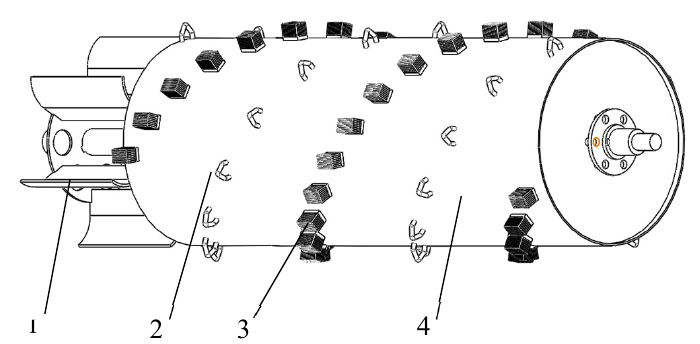
Figure 13. The 3D structure diagram of separation drum. 1. Impurity removal mechanism; 2. Wire- loops; 3. Hairbrush; 4. Closing drum.